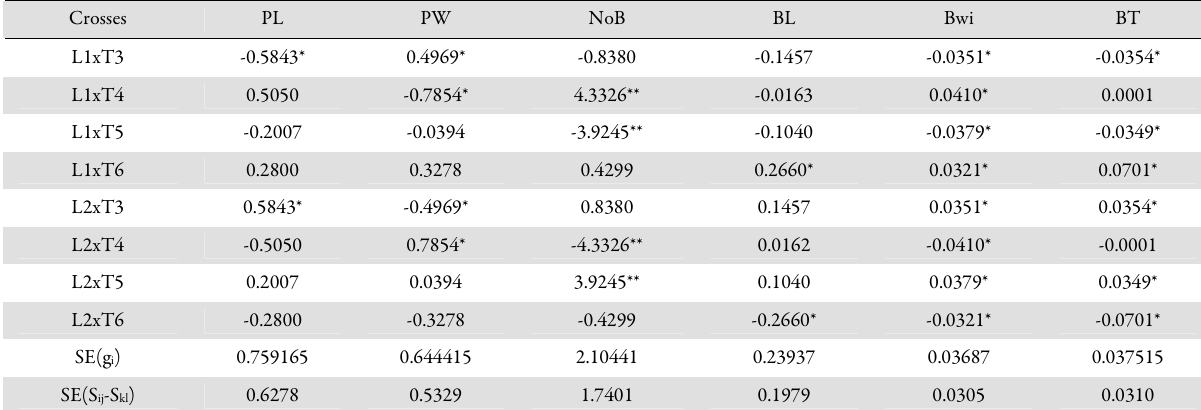
Tab. 6. Specific combining abilities of each line with each tester for the six traits